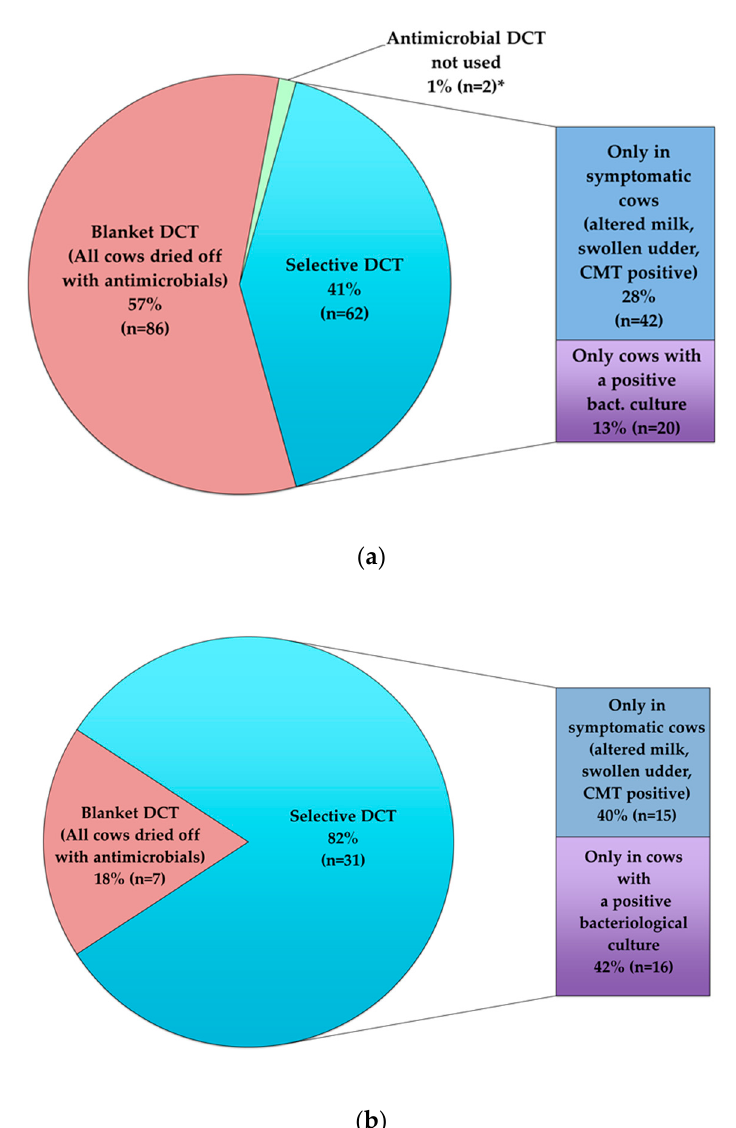
Figure 3. (a) Responses to questionnaire—conventional farmers (n = 150). (b). Responses to Figure3. ( a )Responsestoquestionnaire—conventionalfarmers(n = 150). ( b ).